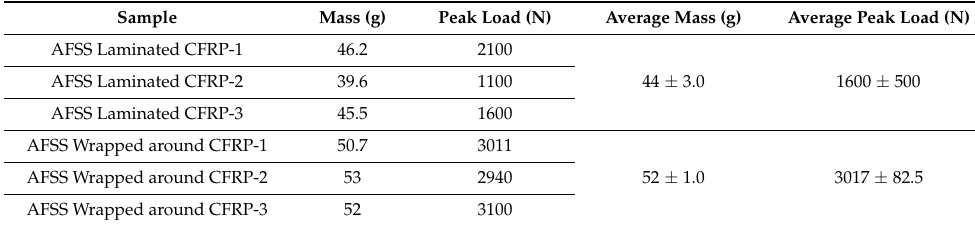
Table 4. The comparison between AFSS and AFSS laminated four layers of CFRP.